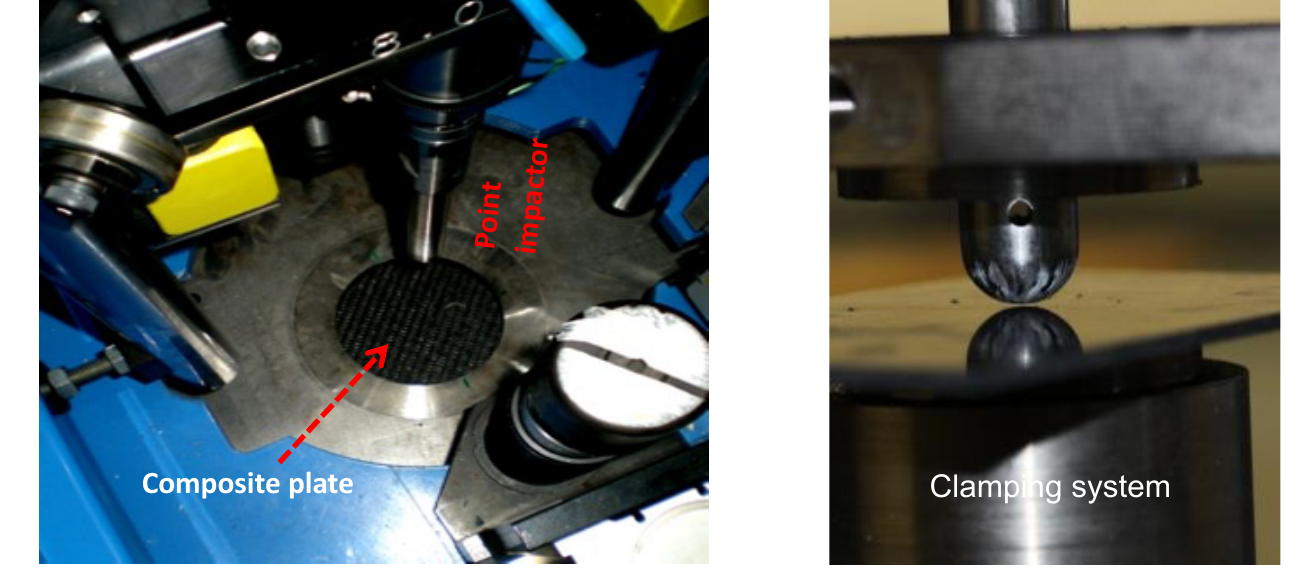
Figure 3. Experiment setup for controlled impact damage of energy equal to 40 Joule.